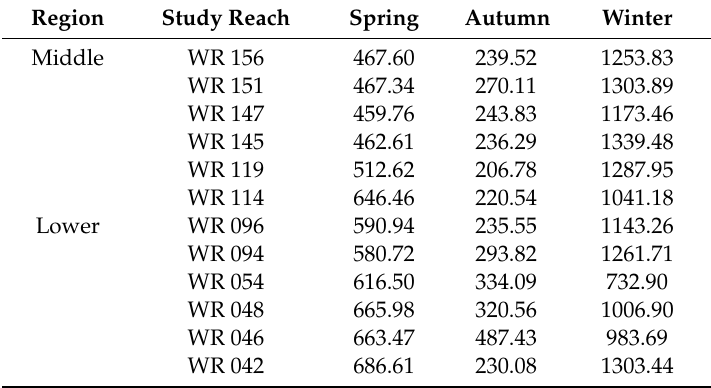
Table 2. In-channel measured discharge (m 3 · s − 1 ) for each of the White River study reaches across two regions (Middle, Lower) and three sampling events (Spring, Autumn, and Winter).